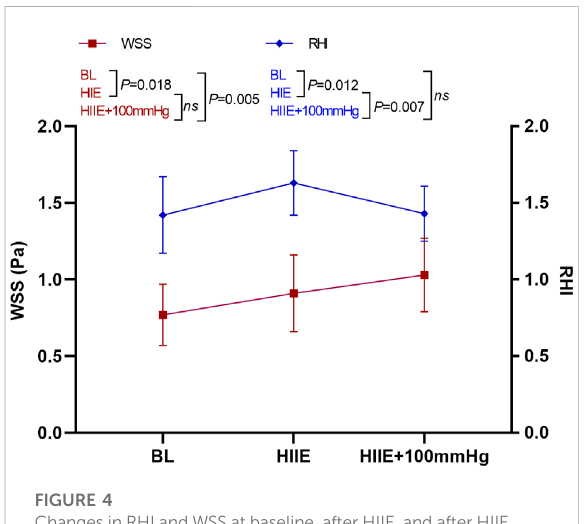
FIGURE 4 Changes in RHI and WSS at baseline, after HIIE, and after HIIE with 100 mmHg in fl ation intervention. Note: RHI, reactive hyperemia index; WSS, wall shear stress.